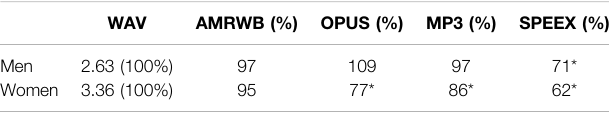
TABLE 1 | Average evaluation of men and women ’ s charisma regarding different compressions denoted as percentual loss compared to high-quality uncompressed speech (WAV).